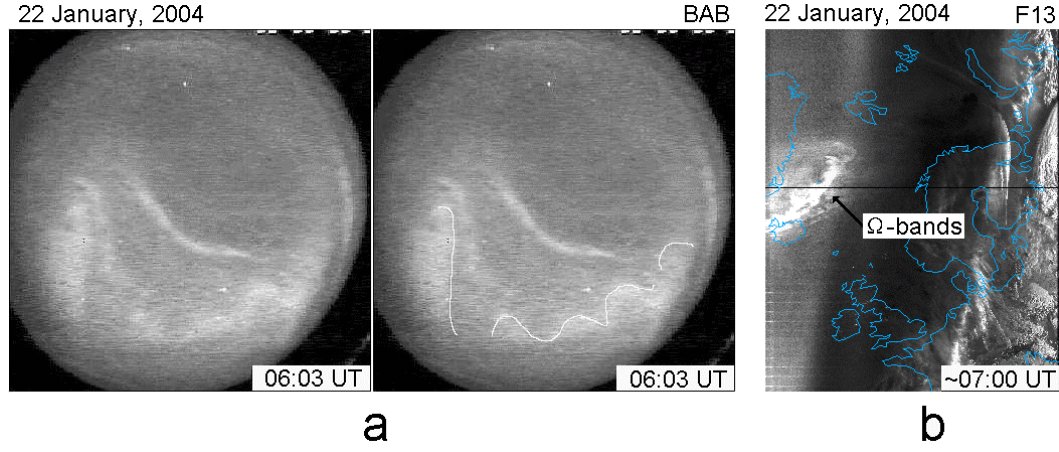
Fig. 6. Omega auroras before the torch passage as seen by the ground based TV camera (a) and after torch passage as seen from the DMSP satellite (b).